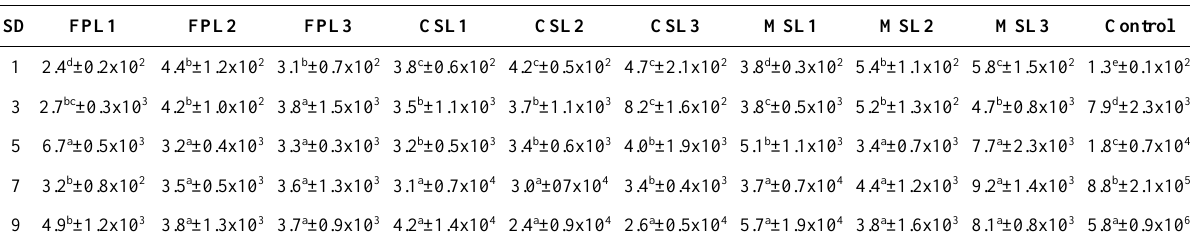
Table 3. Coliform counts (log CFU/g) in the ogiri samples during storage